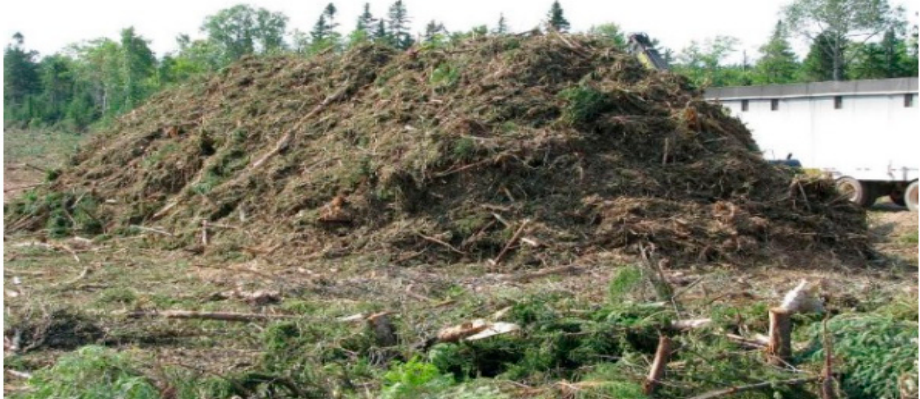
Figure 1. Pile of comminuted forest harvest residue at initial pile construction.